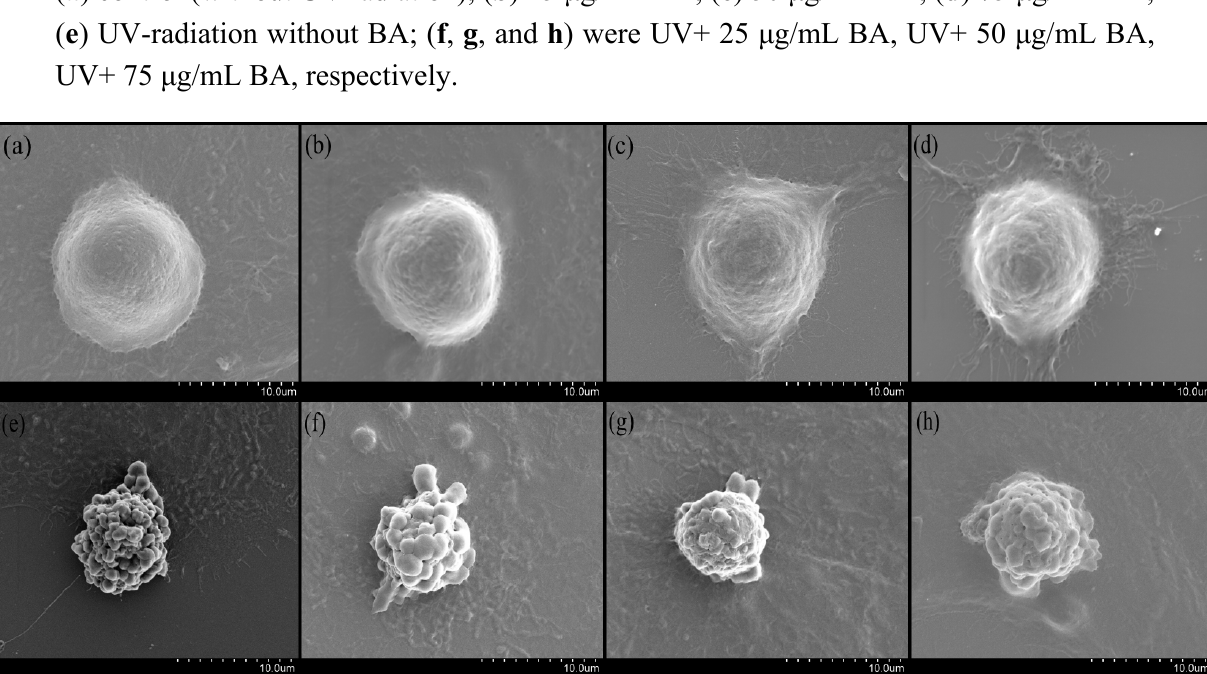
Figure 2. The effects of BA on morphology of UV-irradiated HepG2 cells observed by SEM. Representative photos of cells observed by scanning electron microscopy after pre-treatment for 12 h with BA at different concentrations and then exposed to